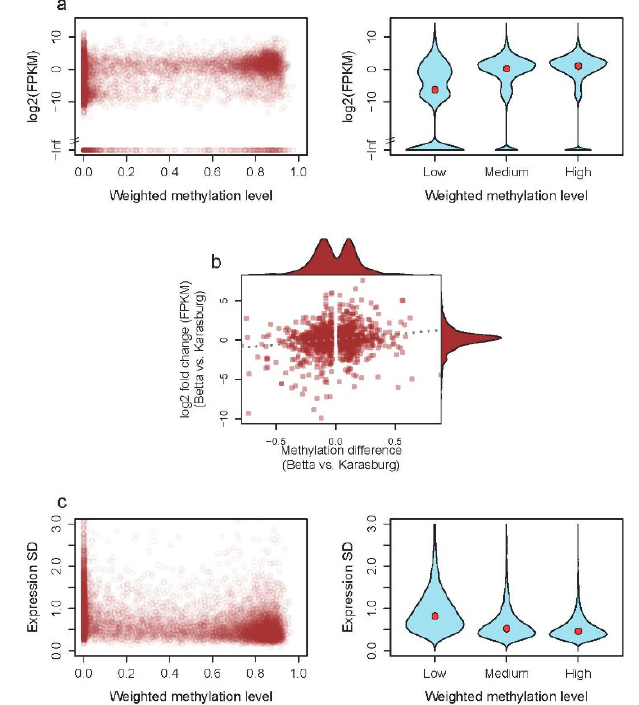
Figure 2. The association between DNA methylation and gene expression in S. dumicola . ( a ) The relationship between gene DNA methylation and gene expression in individuals from the Betta population. Left part, the level of DNA methylation and gene expression (FPKM) is plotted (open circles) per gene. Right part, the same data, but categorized into three categories of DNA methylation levels (low [0–0.2]; medium [0.2–0.7]; high [0.7–1]). All three categories are pairwise significantly different (Wilcoxon rank-sum test, p < 2 × 10 − 16 ). ( b ) Differential gene expression as a function of differential DNA methylation. Expression and DNA methylation differences were estimated and averaged across 10 individuals from each of 10 nests from Betta (B25) and Karasburg (K25) that were acclimated at 25 degrees in the lab for 6 weeks. Each dot represents a gene that passed filtering (see Methods Section 2.6). The dotted grey line is shown to highlight the trend in the data. Spearman’s correlation results in rho = 0.11 and p = 5.6 × 10 − 5 . ( c ) The relationship between the standard deviation (SD) of gene expression (log2 (FPKM)) and the DNA methylation coverage ratio of the 10 individuals from the Betta population acclimated at 25 degrees. Only genes that were expressed in all individuals are included.